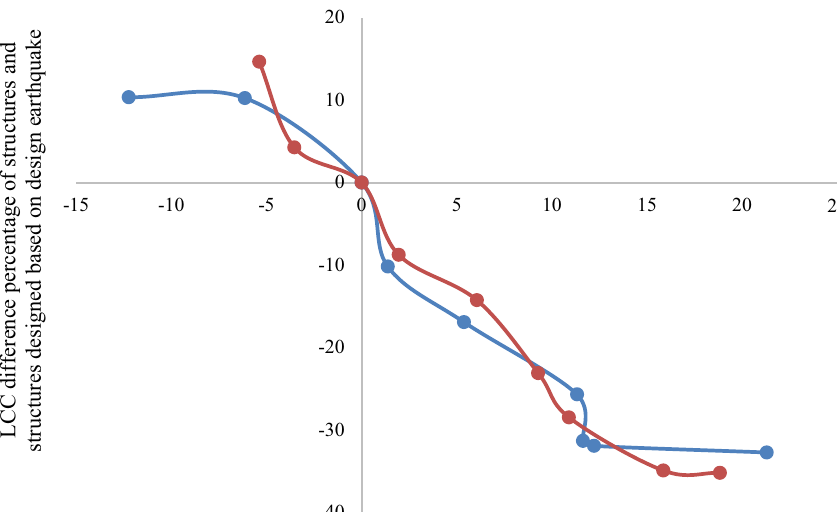
Weight difference percentage of structures and structures designed based on design earthquake 7 Story - Regular 7 Story - Irregular Figure 10. Weight and LCC difference of 7-story models based on the design earthquake (in percentage).